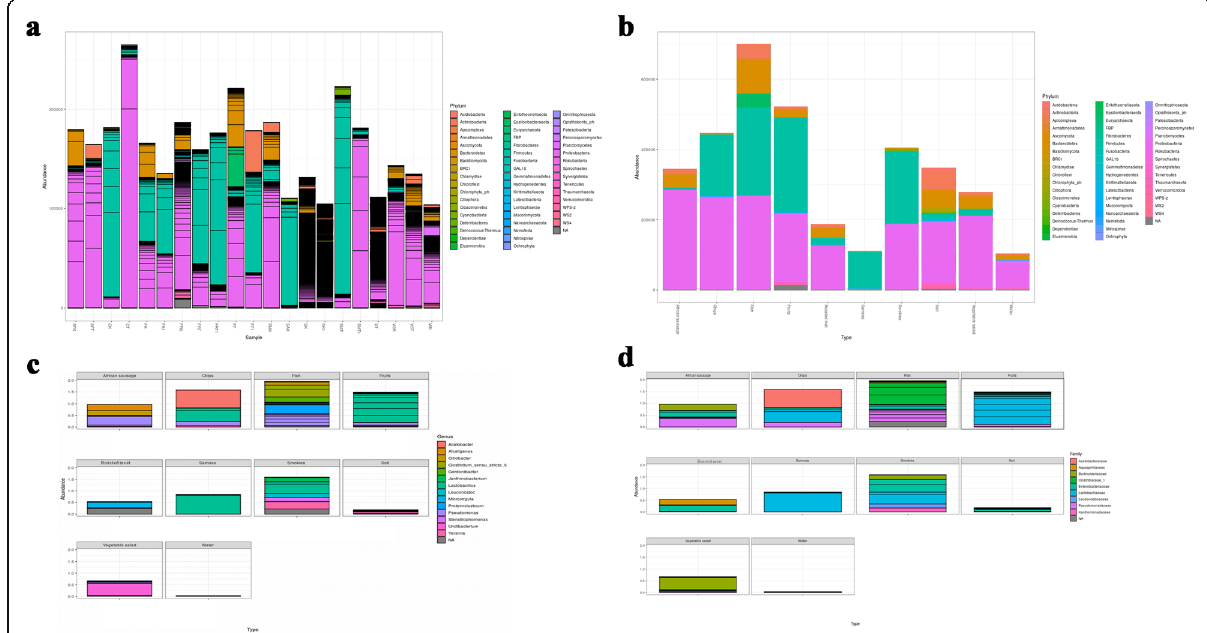
Fig. 2 a Relative abundance of most predominant bacteria at phyla level in respective samples from vended food and environmental samples from Kangaru Market and Embu Town. b Relative abundance of bacteria phyla in combined vended food and environmental samples from Embu Town and Kangaru Market. c Predominant bacteria genera in vended food and environmental samples from Embu Town and Kangaru Market. d Relative abundance of the most predominant bacteria families in vended food and environmental samples from Kangaru Market and Embu Town. Key: African Sausage Kangaru (AFK), African Sausage Town (AFT), Chips Kangaru (CK), Chips Town (CT), Fish Kangaru (FK), Fruits Kangaru (FRK), Fruits Town (FRT), Fish Town (FT), Roasted Meat Kangaru (RMK), Samosa Kangaru (SAK), Kangaru Soil (SK), Smokies Town (SMT)), Town Soil (ST), Vegetable Salad Kangaru (VSK), Vegetable Salad Town (VST), Water Kangaru